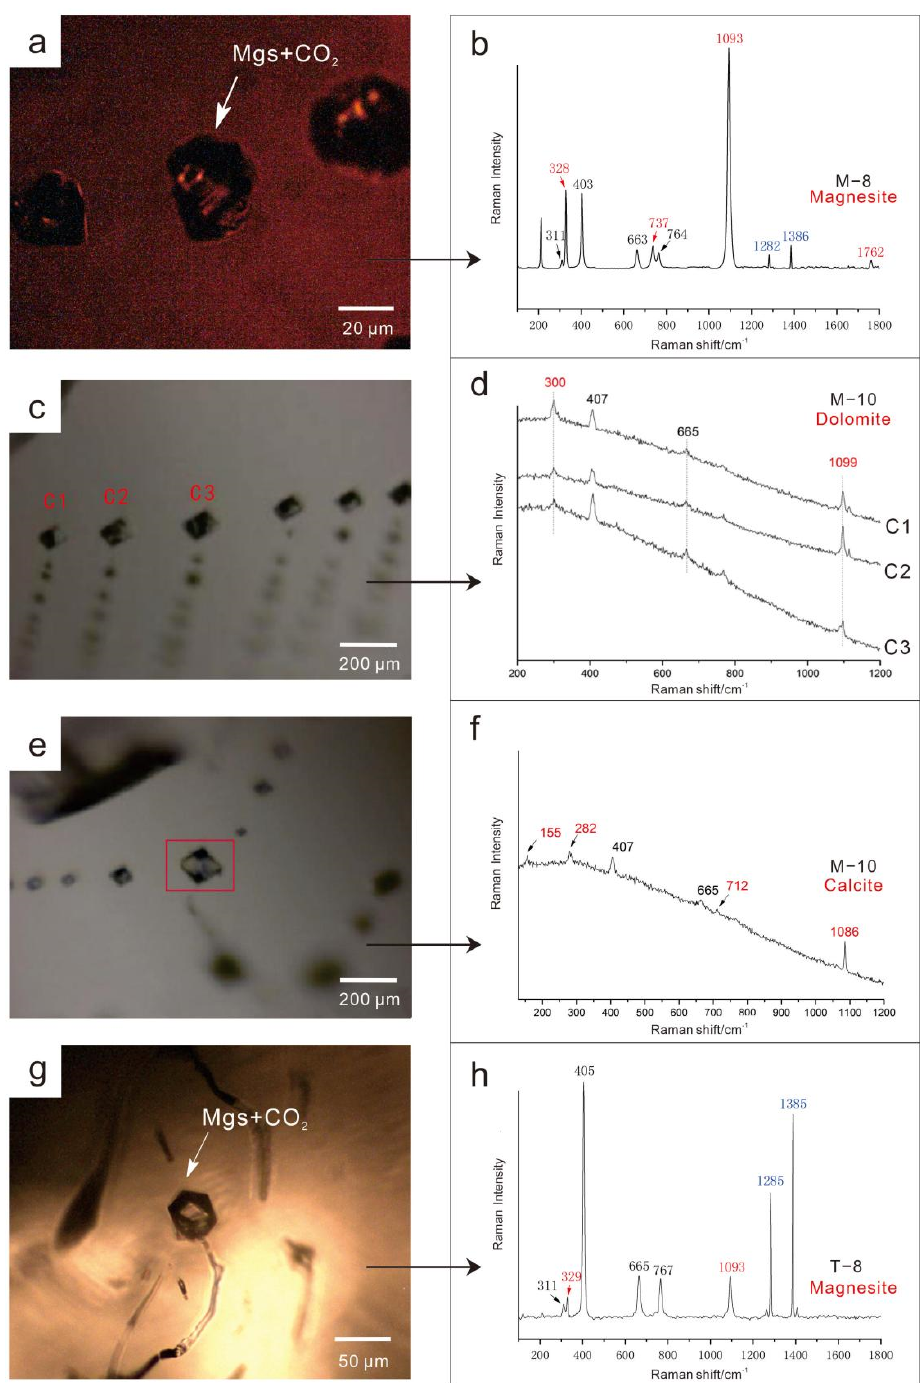
Figure 9. ( a ) Magnesite inclusion in Myanmarese spinel (M − 8) and ( b ) its (M − 8) Raman spectrum. ( c ) Dolomite inclusions in Myanmarese spinel (M − 10) and ( d ) their (M − 10) Raman spectra. ( e ) Calcite inclusion in Myanmarese spinel (M − 10) and ( f ) its (M − 10) Raman spectrum. ( g ) Magnesite inclusion in Tajikistani spinel (T − 8) and ( h ) its (T − 8) Raman spectrum.